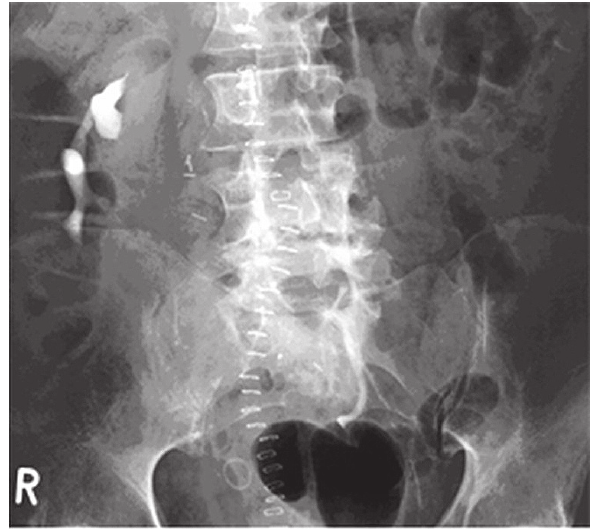
Fig. 3 - Pielografia intravenosa